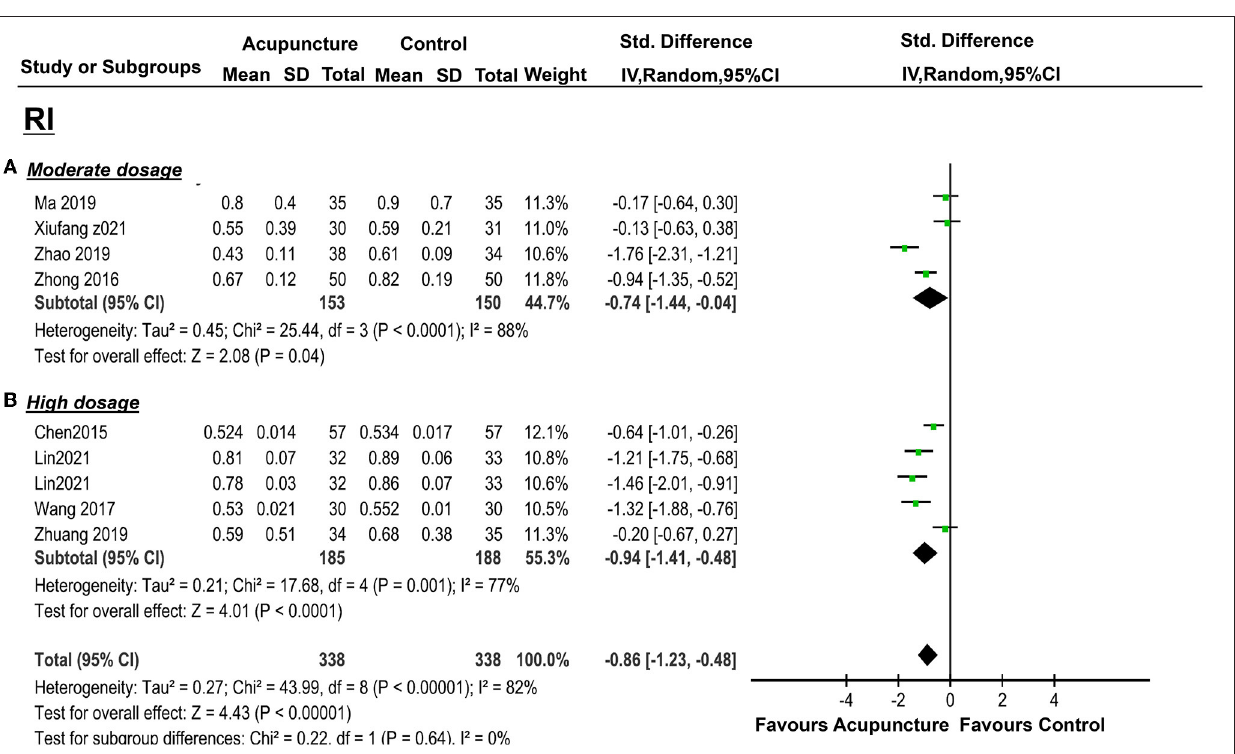
FIGURE 8 | Effects of acupuncture on RI based on intervention of moderate dosage (A) and high dosage (B) .